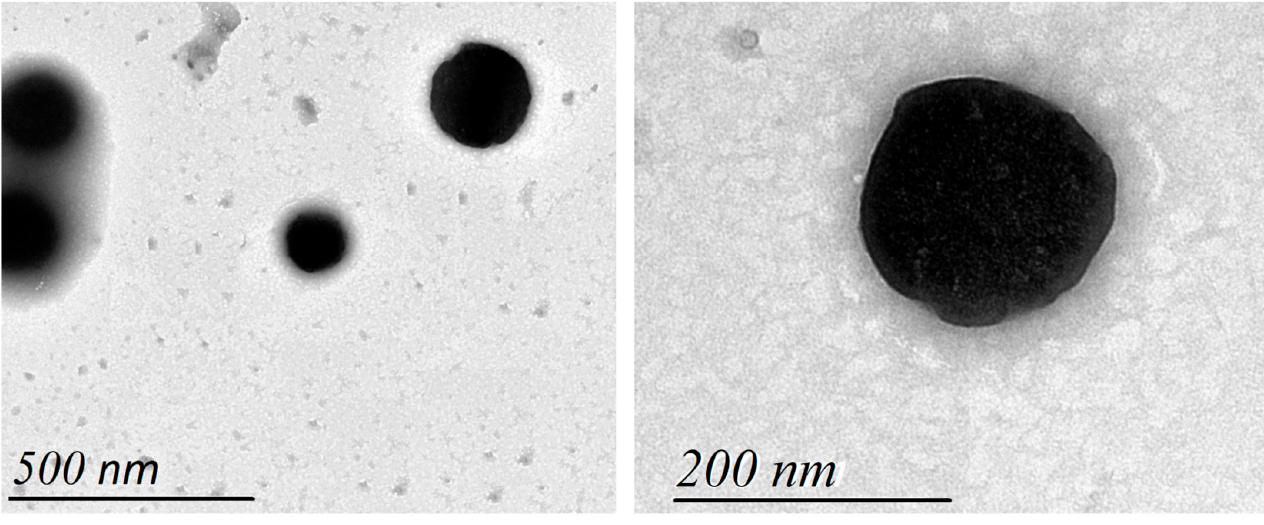
Figure 2. Transmission electron microscopy of optimum ALN formulation.